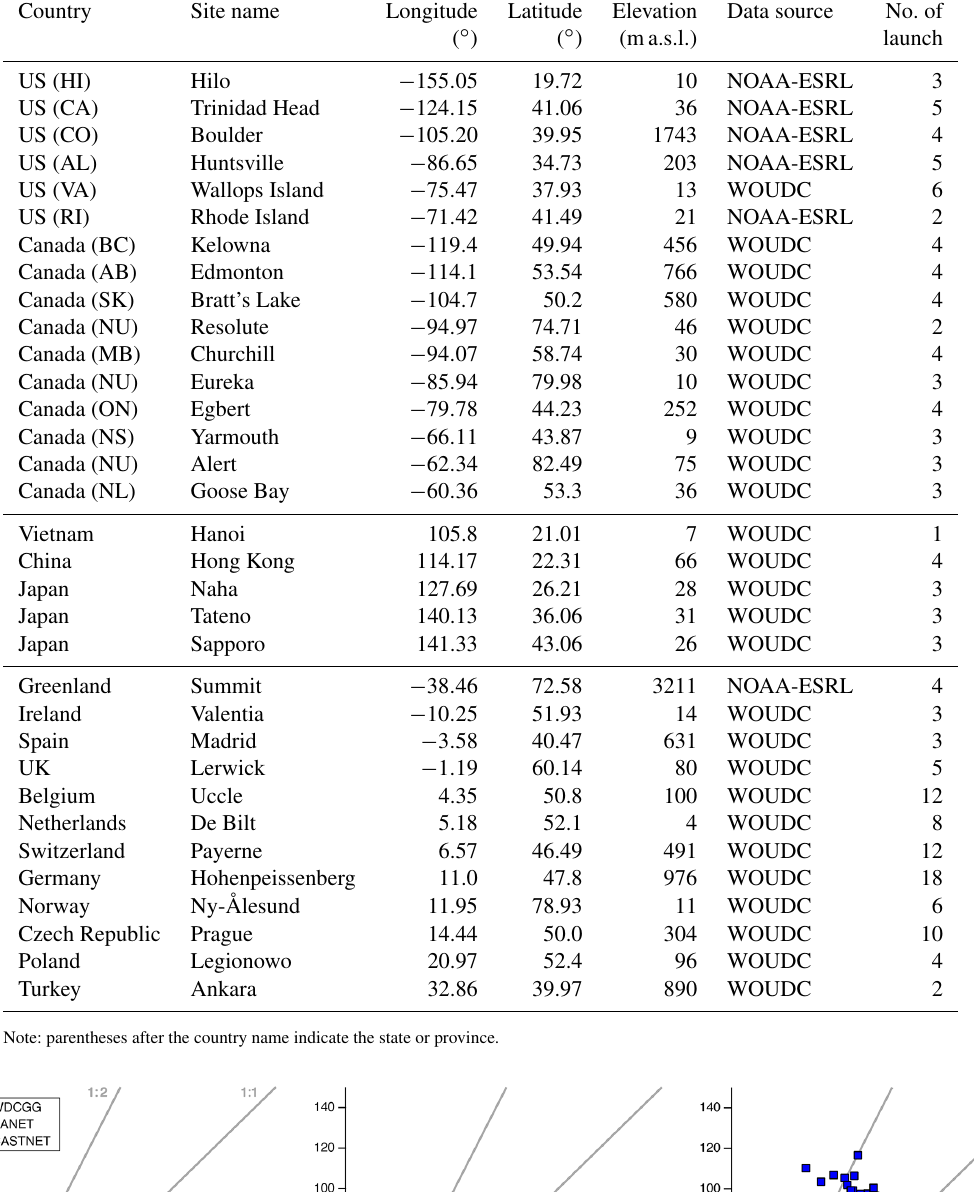
Table 2. Details of the ozonesonde dataset used in this study. Country